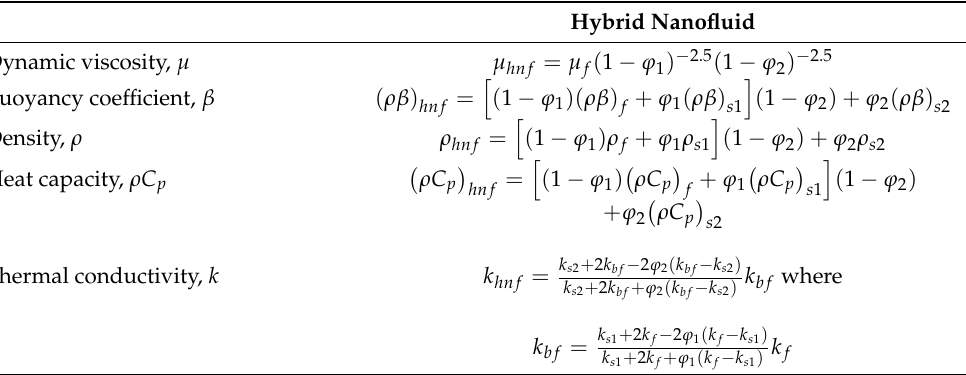
Table 1. Applied models for physical characteristics of hybrid nanofluid and nanofluid (see Devi and Devi